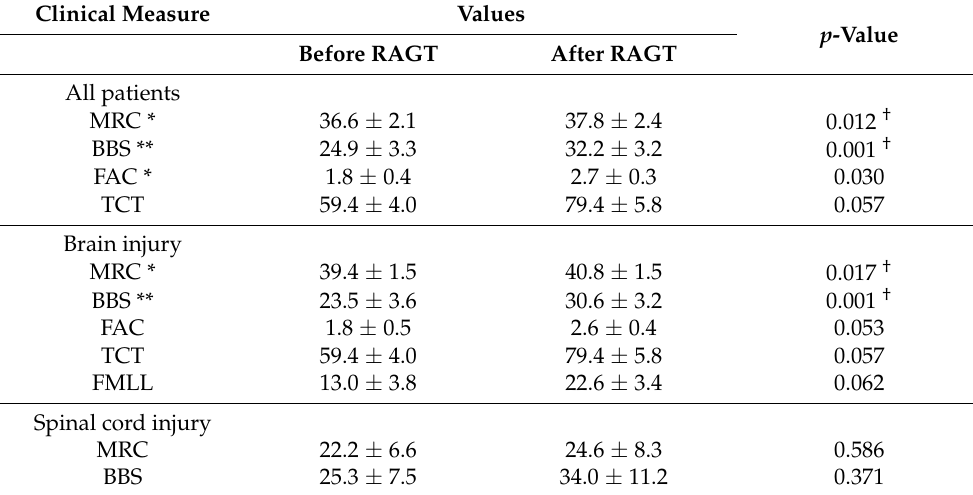
Table 2. Changes in clinical outcomes before and after RAGT.